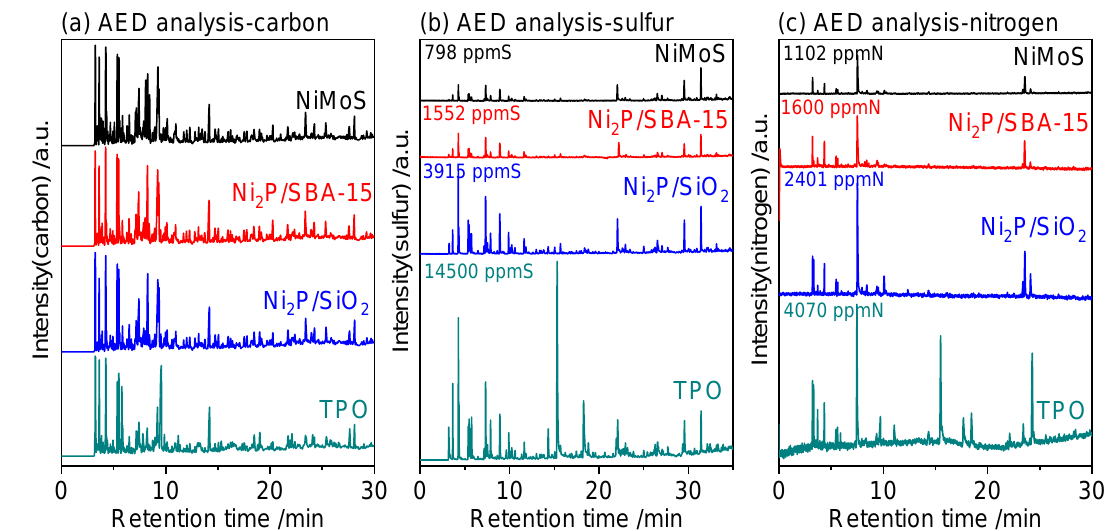
Figure 4. AED chromatographs of hydrotreating products on NiMoS, Ni 2 P/SBA-15, and Ni 2 P/SiO 2 catalysts at 3.0 MPa, 350 ◦ C, LHSV of 0.5 h − 1 , and time on stream of 12 h. ( a ) AED analysis-carbon, ( b ) AED analysis-sulfur, and ( c ) AED analysis-nitrogen.